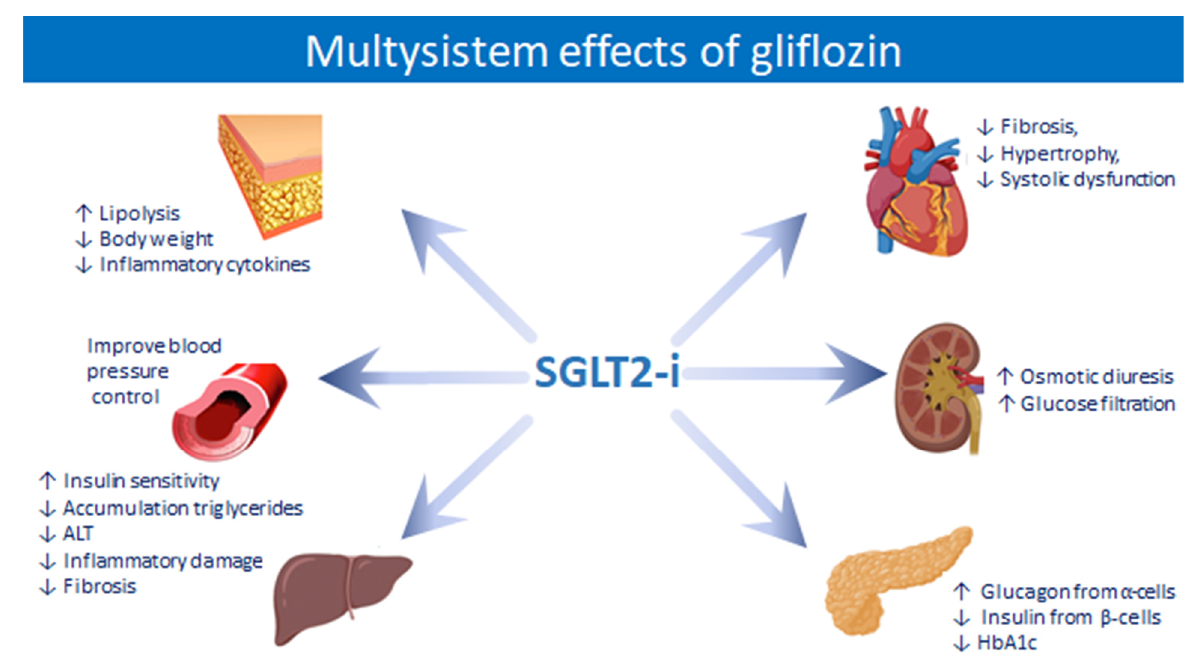
Figure 2. Effects of SGLT2-I on several organs and functions 。